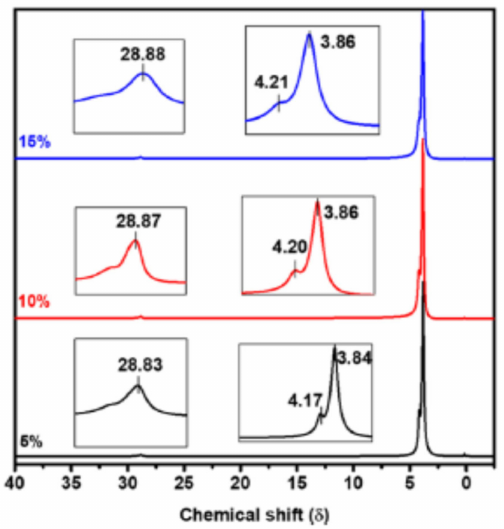
Figure 13. 1 H NMR spectra (9.4 T) of PEO-LiClO 4 membrane containing various mass percentages of SiO 2 . Reprinted with permission from [102]. Copyright 2020 American Chemical